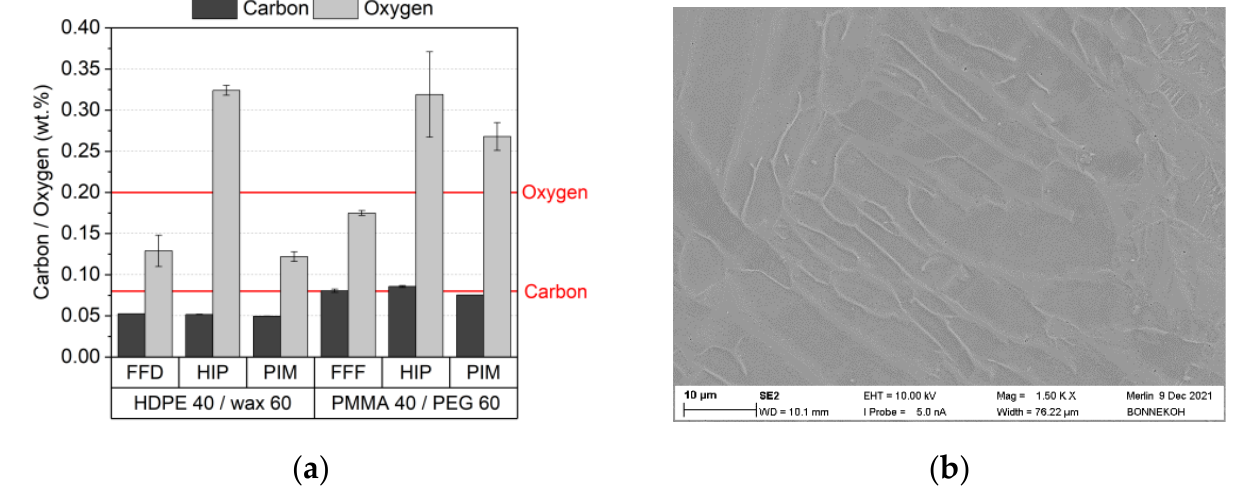
Figure 20. ( a ) Elemental analysis after sintering and HIP applying different replication methods. The red line represents the maximum allowed values according to [27,52]. ( b ) SEM image of sintered and additional HIPed microstructure (initial composition: PEG (8000)60/PMMA40, 5 wt% PAT-77P. solid load 60 vol%, FFF printing, density 99.9 %).